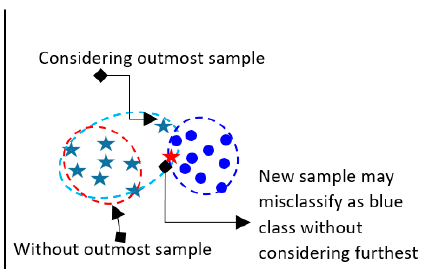
Figure 4. Consideration of outmost sample of a class.